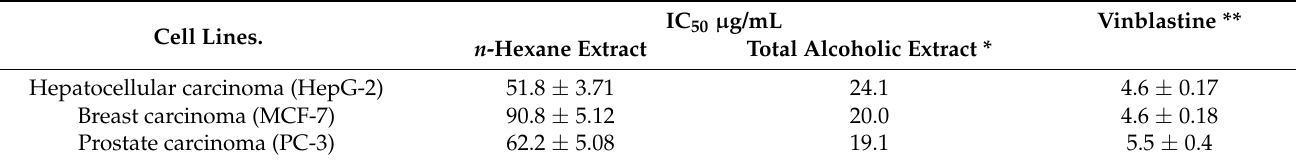
Table 2. Cytotoxicity of the Pulicaria jaubertii n -hexane extract. Cell